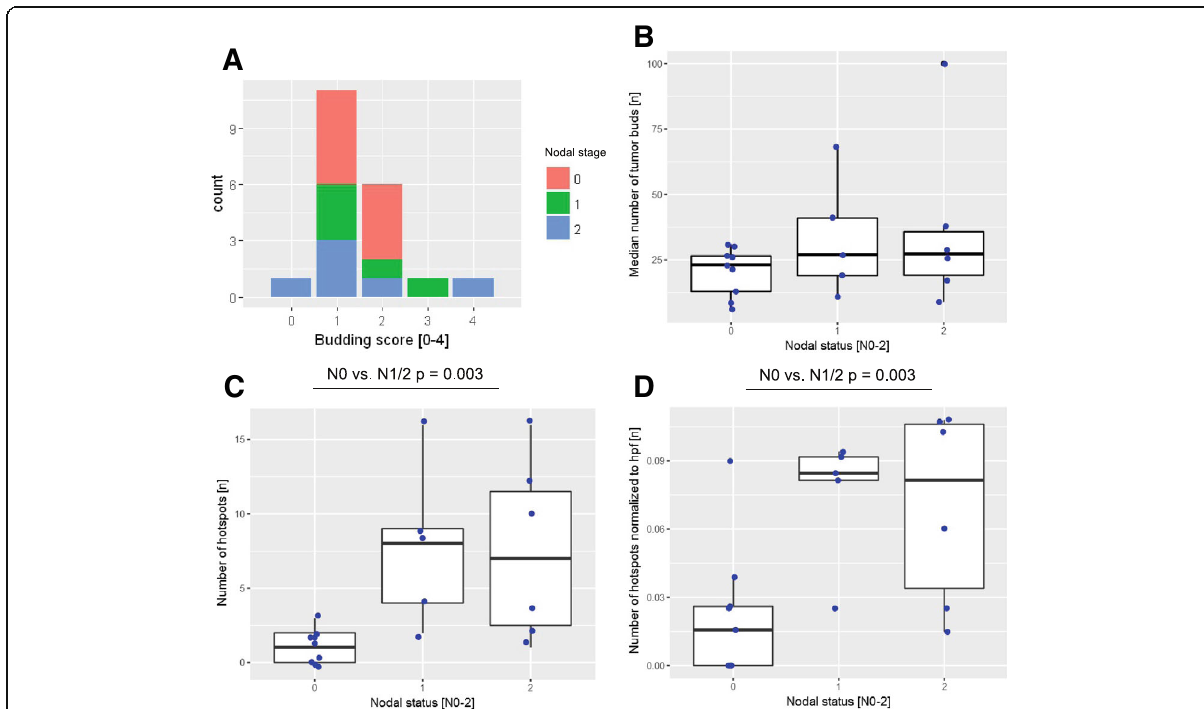
Fig. 4 Analysis of vTMAs from 20 cases. From 20 selected cases (pN0 ( n =9), pN1 ( n =5), pN2 ( n =6)) one pan-cytokeratin-stained slide was digitalized and disassembled into virtual, overlapping vTMA cores ( n =290±152). a No significant correlation was detected between the resulting budding score and the nodal status and b the median number of tumor buds within the 10 hottest spots and the nodal status for the complete ROI border. c , d Significant positive correlation between the nodal status and the absolute number of significant budding hotspots and the normalized number of significant budding hotspots. The latter is done to compensate for a trend toward higher tumor areas on the WSI for pN1 and pN2